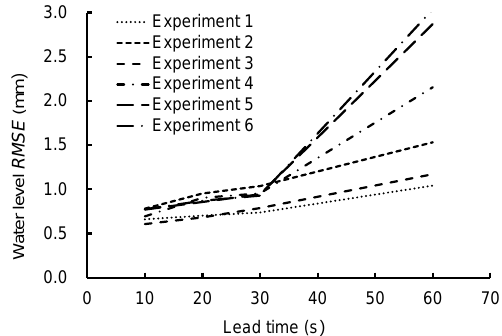
Figure 7. RMSE s of water level prediction for different lead times in different experiments.